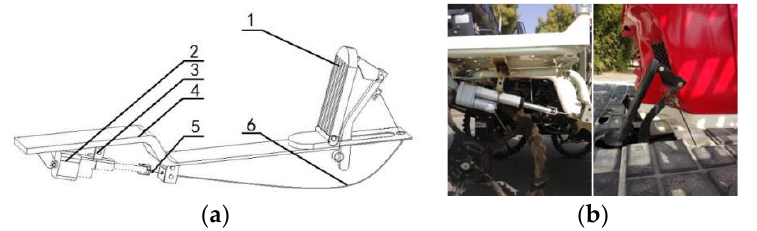
Table 3. Parameters of the electric push rod.